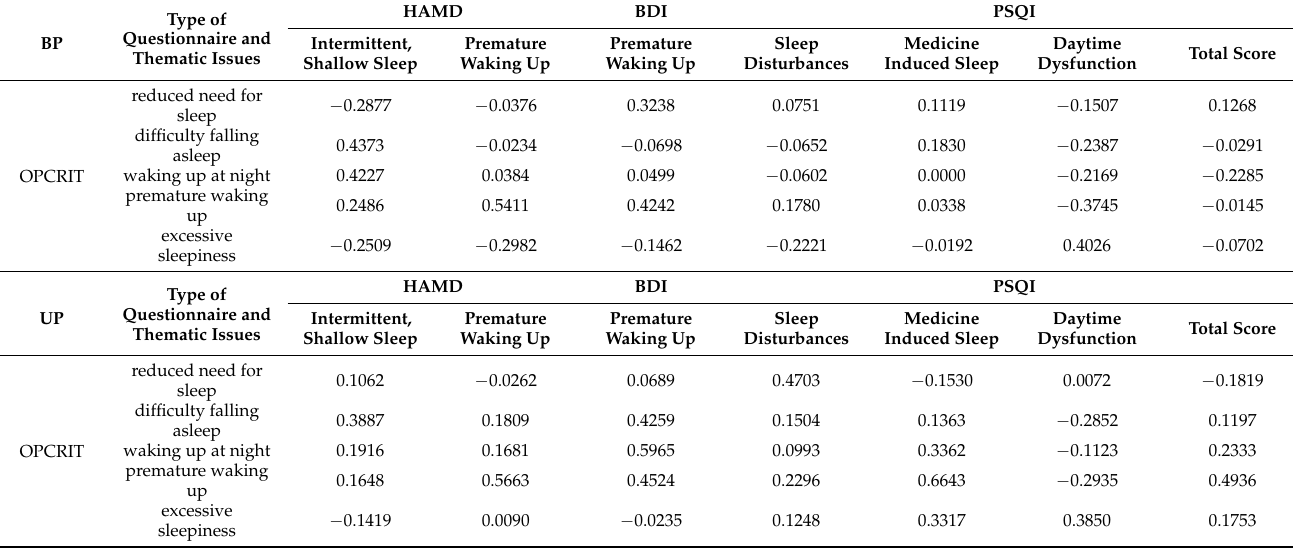
Table 4. Correlation of sleep issues between different questionnaire for BP and UP